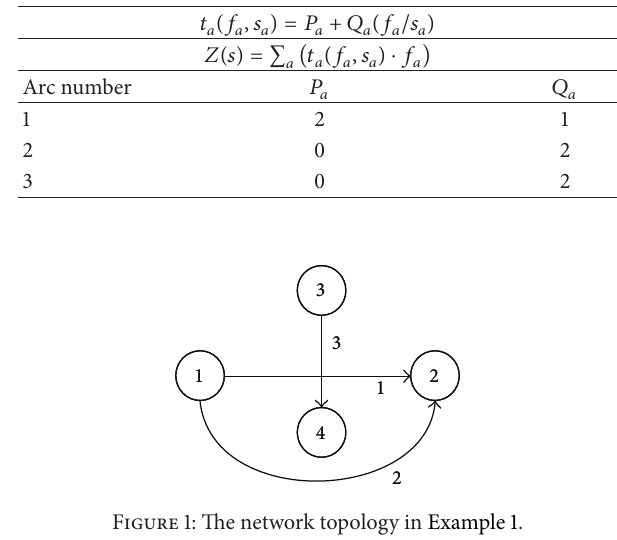
Table 1: Arc cost functions and the system objective function in Example 1.